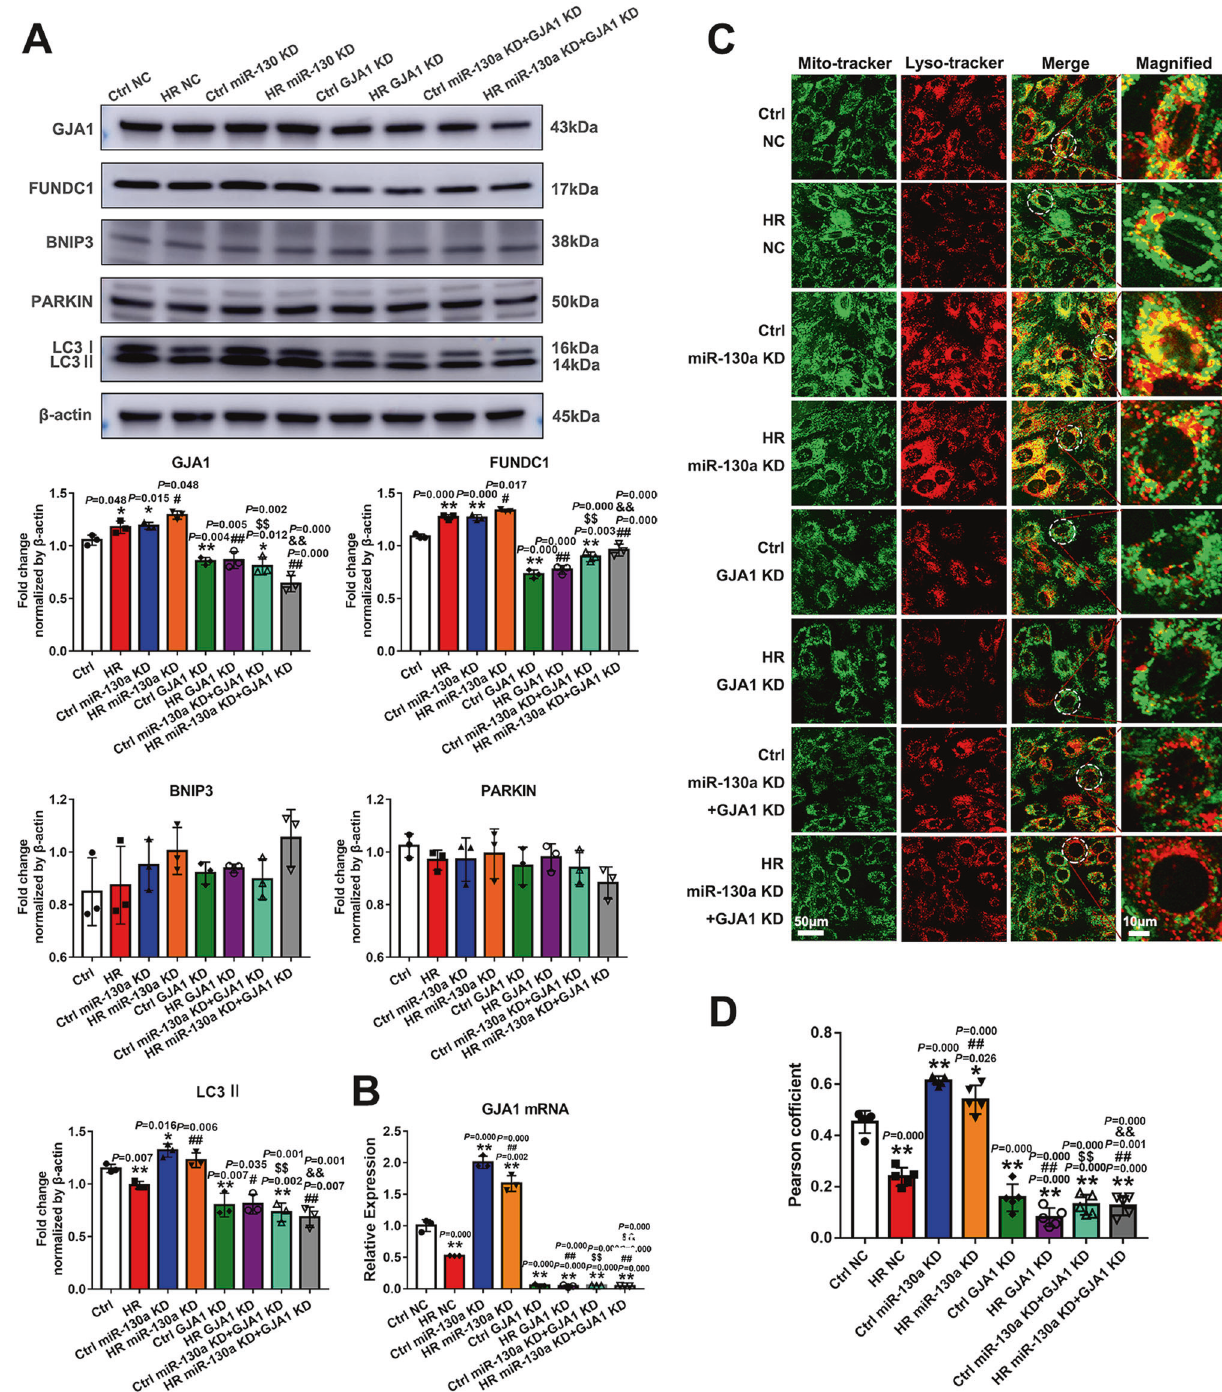
Fig. 7 GJA1 was required for miR-130a to aggravate mitochondrial dysfunction in myocardial HRI. A The levels of GJA1, FUNDC1, PARKIN, BNIP3, and LC3 were measured by Western blot and quanti fi ed. n = 3 in each group. B The mRNA level of GJA1 expression was detected by qRT-PCR. n = 3 in each group. C The co-localization experiments were performed to observe mitophagy activity. Cells were stained with Mito- tracker (green) and Lyso-tracker (red). Scale bars, 50 μ m and 10 μ m in magni fi ed. D The quantitative analysis of the co-localization of lysosome and mitochondria was assessed by the Pearson ’ s correlation coef fi cient. Data were expressed as mean ± SD; Statistical signi fi cance by two- tailed Student ’ s t-test, * P < 0.05, ** P < 0.01 vs. Ctrl NC; # P < 0.05, ## P < 0.01 vs. HR NC; $$ P < 0.01 vs. Ctrl miR-130a KD; && P < 0.01 vs. HR miR- 130a